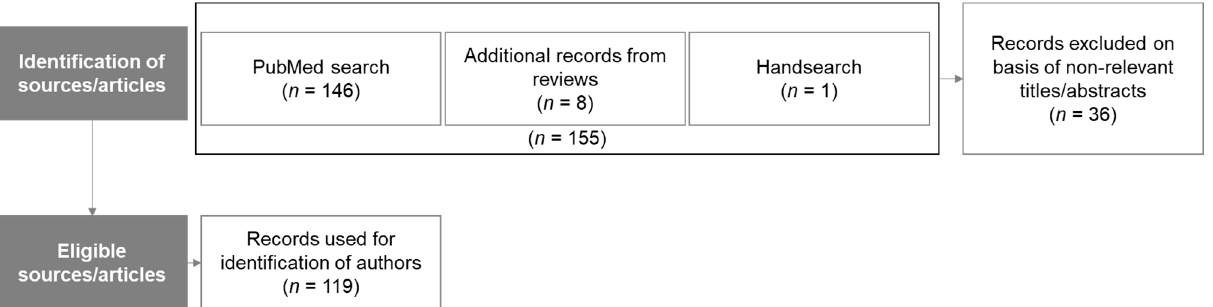
Figure 1. Overview of selection process for relevant publications.